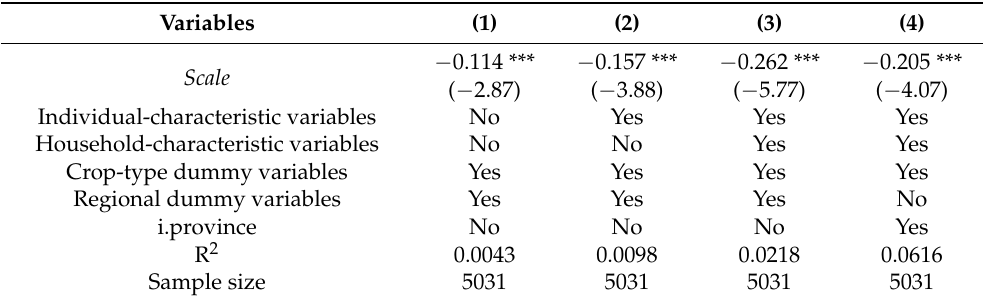
Table 2. The impact of the scale of cultivated land management on the amount of fertilizer expenditure per hectare.